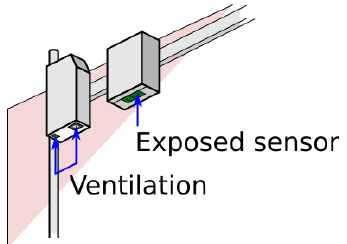
Figure 16. Experimental setup for investigating aspirated (on the left) vs. passive sampling (right side), on the AURN